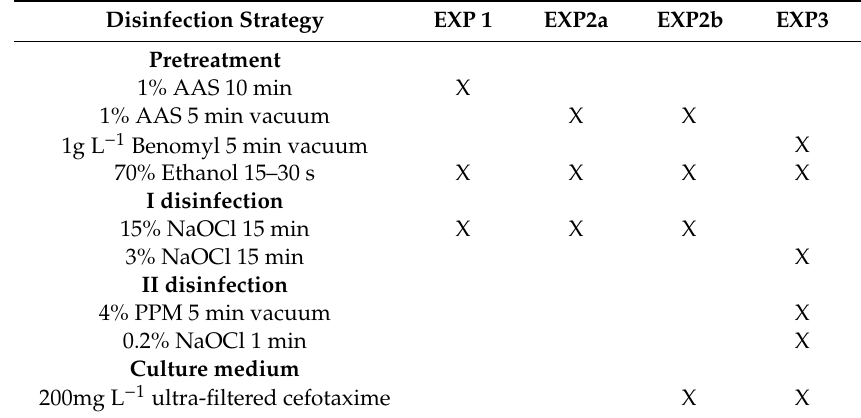
Table 1. Disinfection strategy applied in di ff erent experiments (EXP 1, 2a, 2b and 3) to Pitaya stem explants to start the micropropagation process.